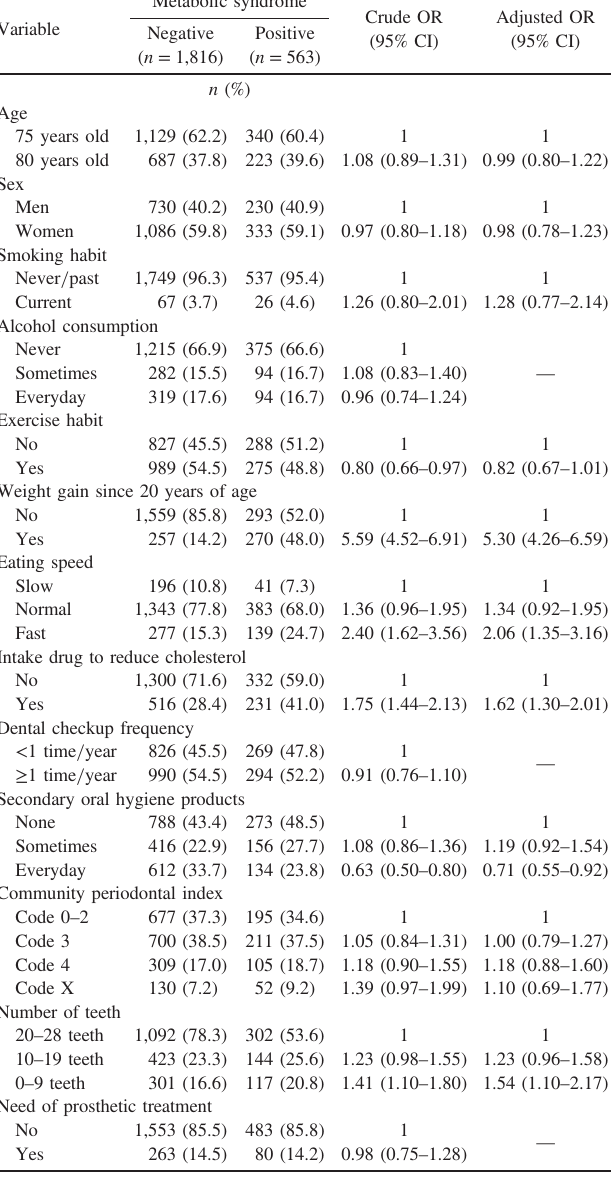
Table 2. Relation of oral health, life-style factors, and